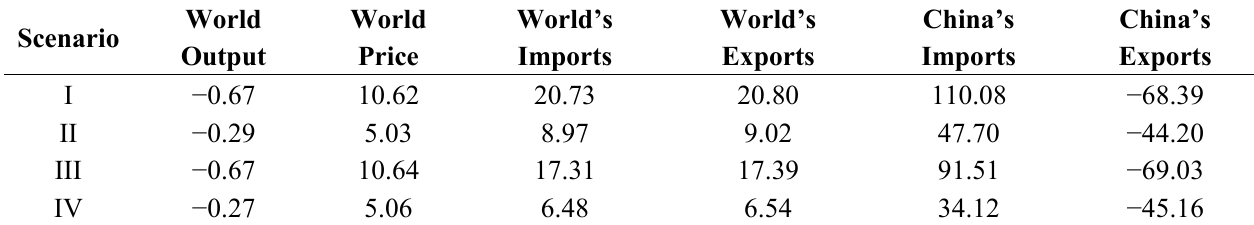
Table 4. Percentage changes in China’s imports and exports and global markets of forestry